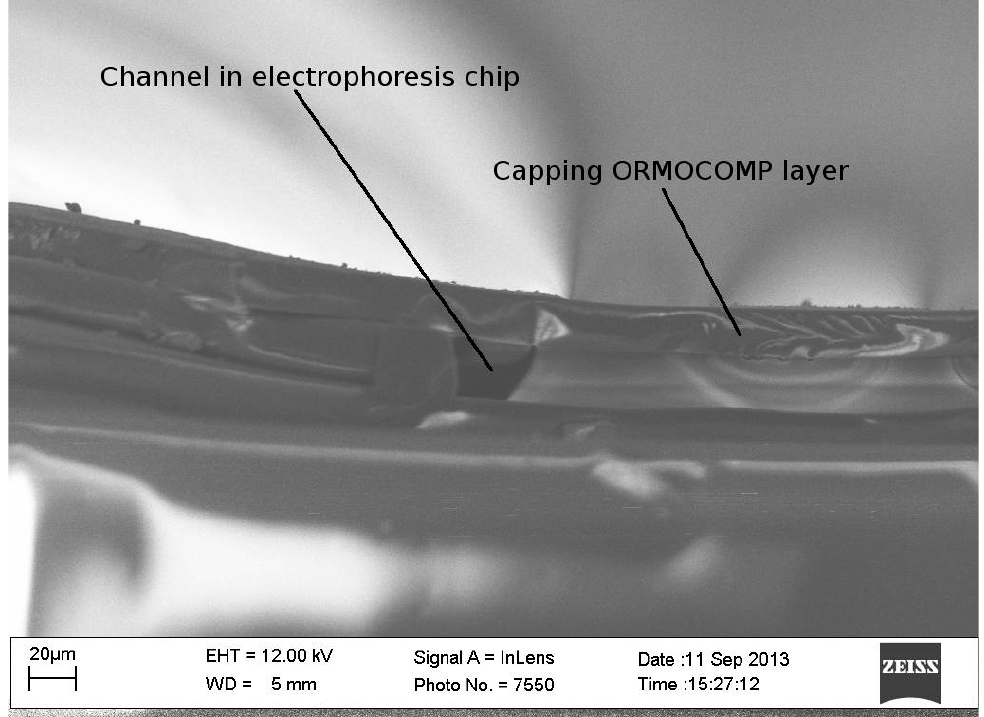
Figure 8. SEM image of channel in electrophoresis chip. The top ORMOCOMP ® capping layer is visible.